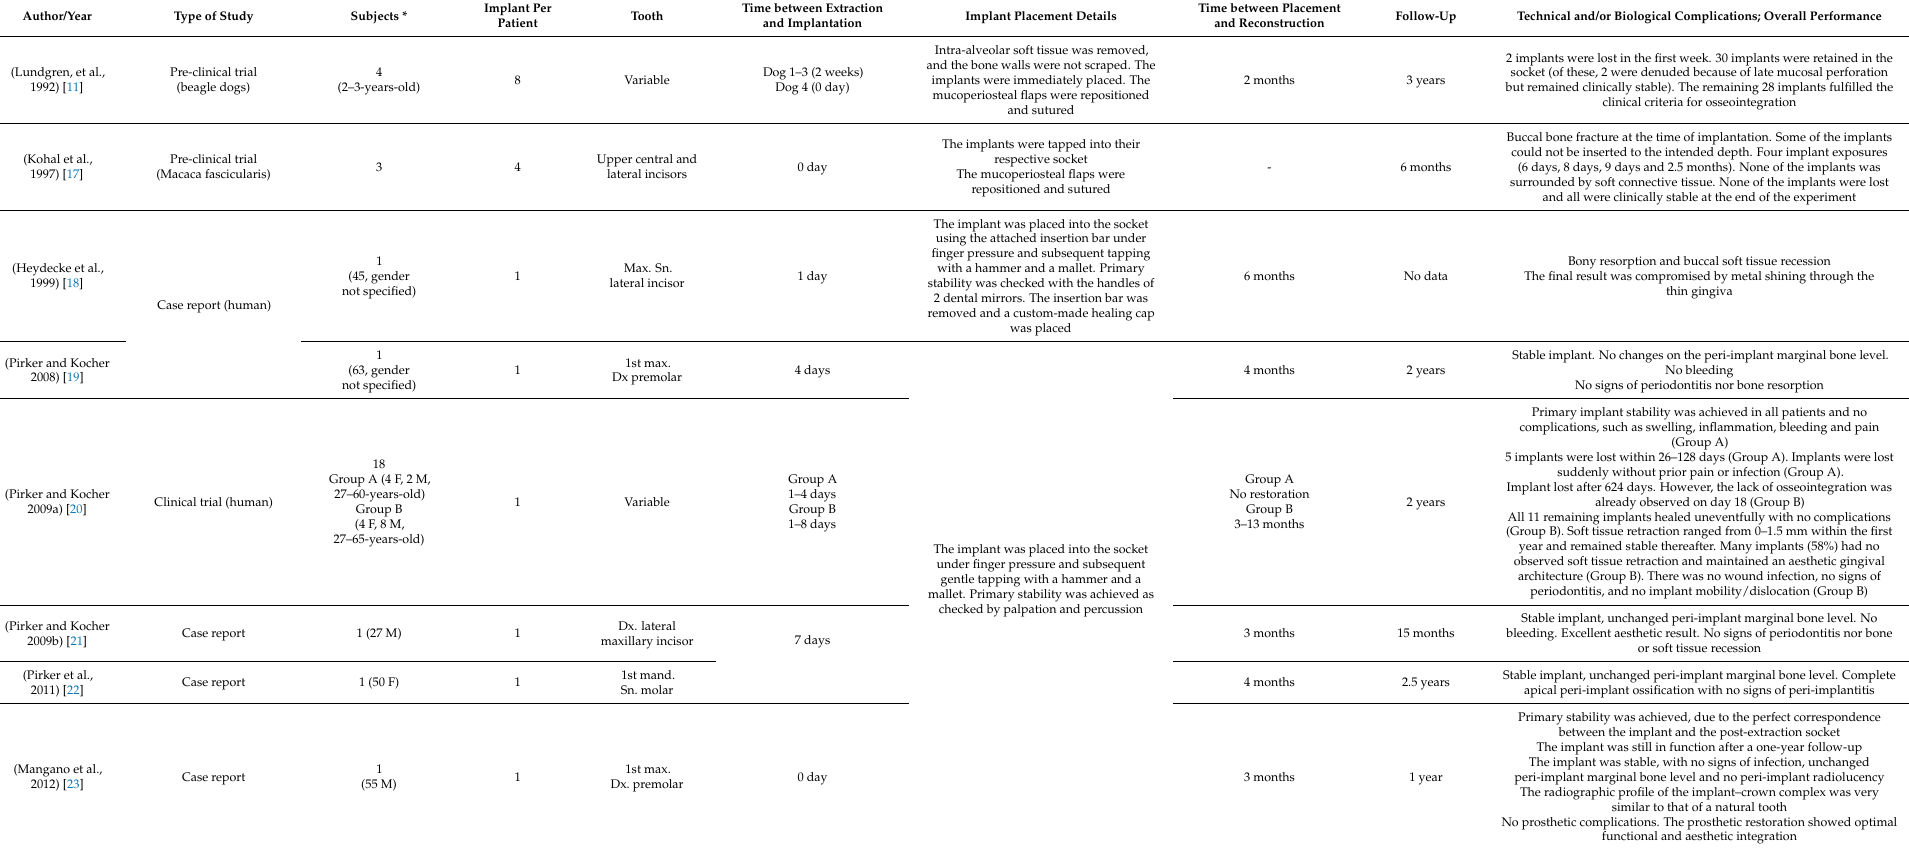
Table 3. Summary of the clinical trials/case reports parameters and